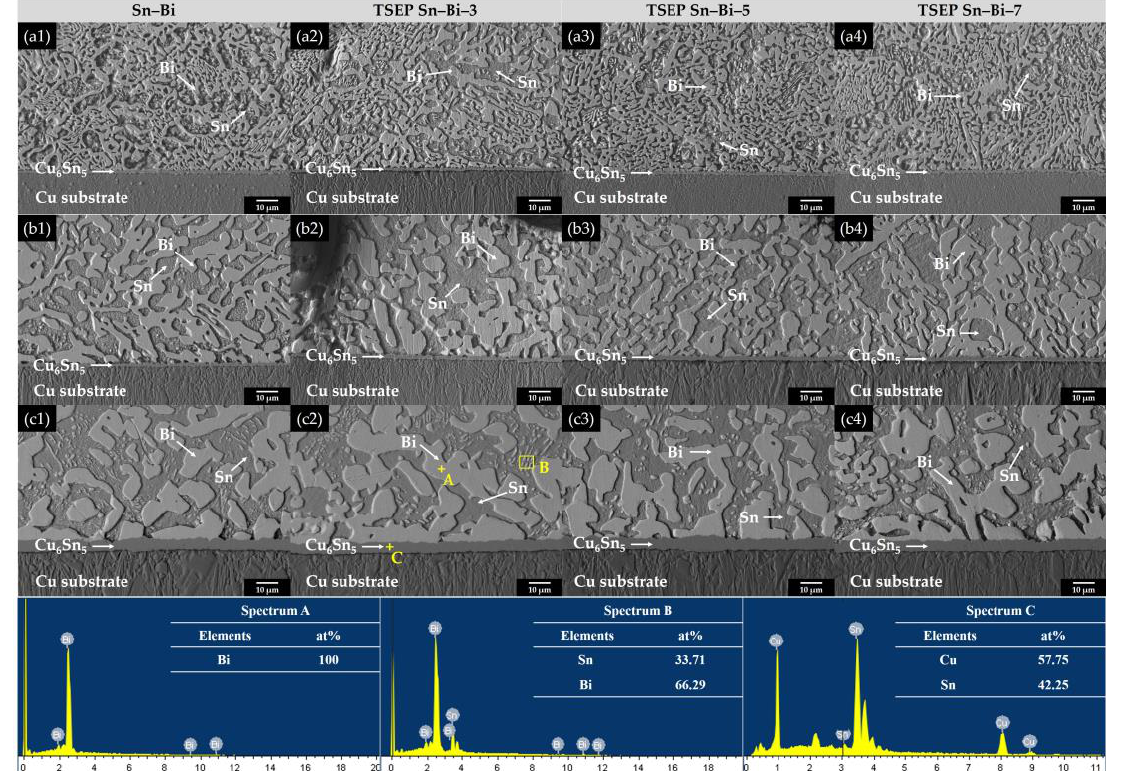
Figure 6. The microstructure of Sn – Bi/Cu solder joints and TSEP Sn – Bi-x/Cu solder joints: ( a1 – a4 ) Solder joints after soldering; ( b1 – b4 ) Solder joints after TH 1000 h; ( c1 – c4 ) Solder joints after TC 1000 cycles.